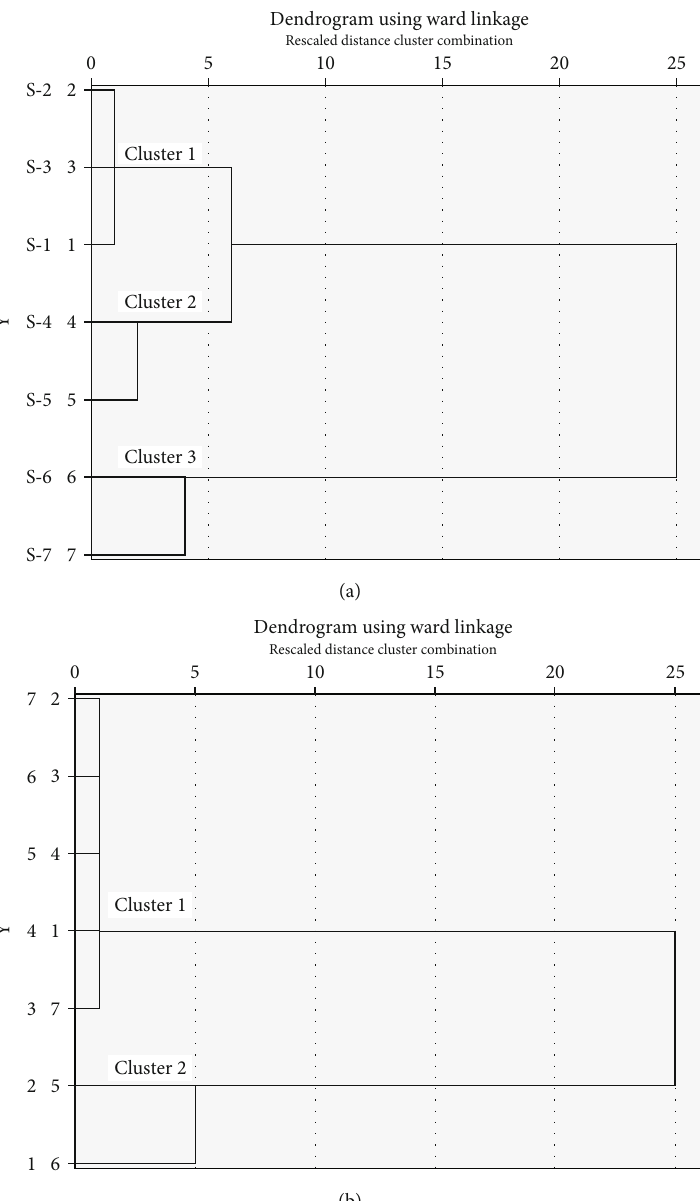
Figure 3: (a) Dendrogram of cluster analysis for sampling stations according to surface water quality parameters of the Soan River (premonsoon). (b) Dendrogram of cluster analysis for sampling stations according to surface water quality parameters of the Soan River